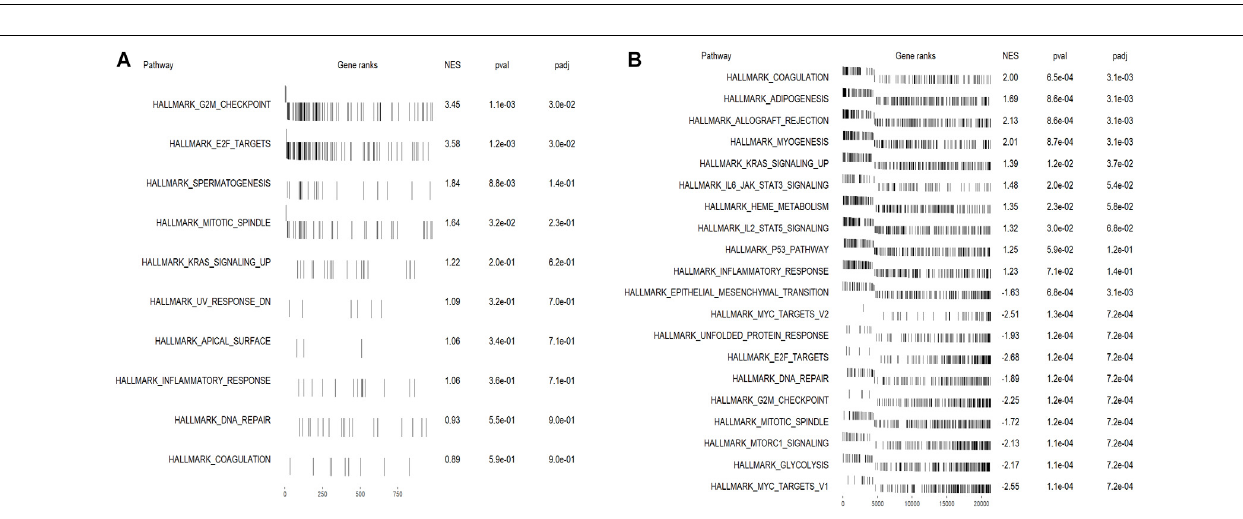
FIGURE 6 | The top enriched gene sets in up- and down-regulated DEGs in the high-risk group. (A) Gene sets enriched in DEGs up-regulated in the high-risk group. G2M checkpoints and E2F target-related genes were significantly enriched. (B) Gene sets enriched in DEGs down-regulated in the high-risk group. Genes related to interleukin, STAT, KRAS, and p53 were enriched, while cell mitosis-related genes were significantly deprived.